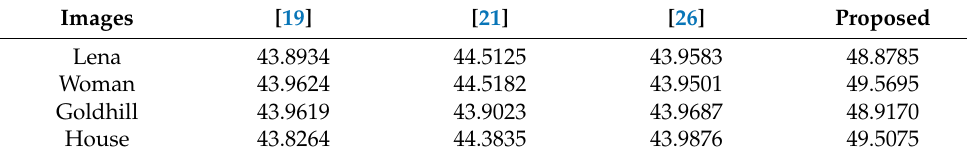
Table 4. The comparison of the invisibility based on PSNR values without attack.